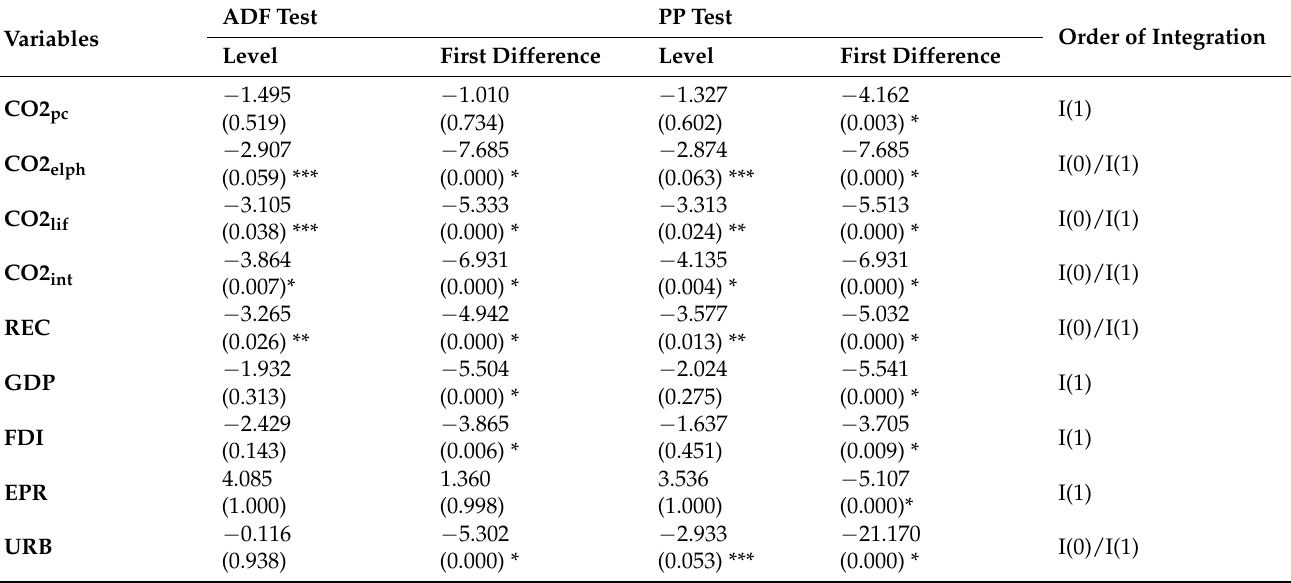
Table 3. Unit root tests analysis.